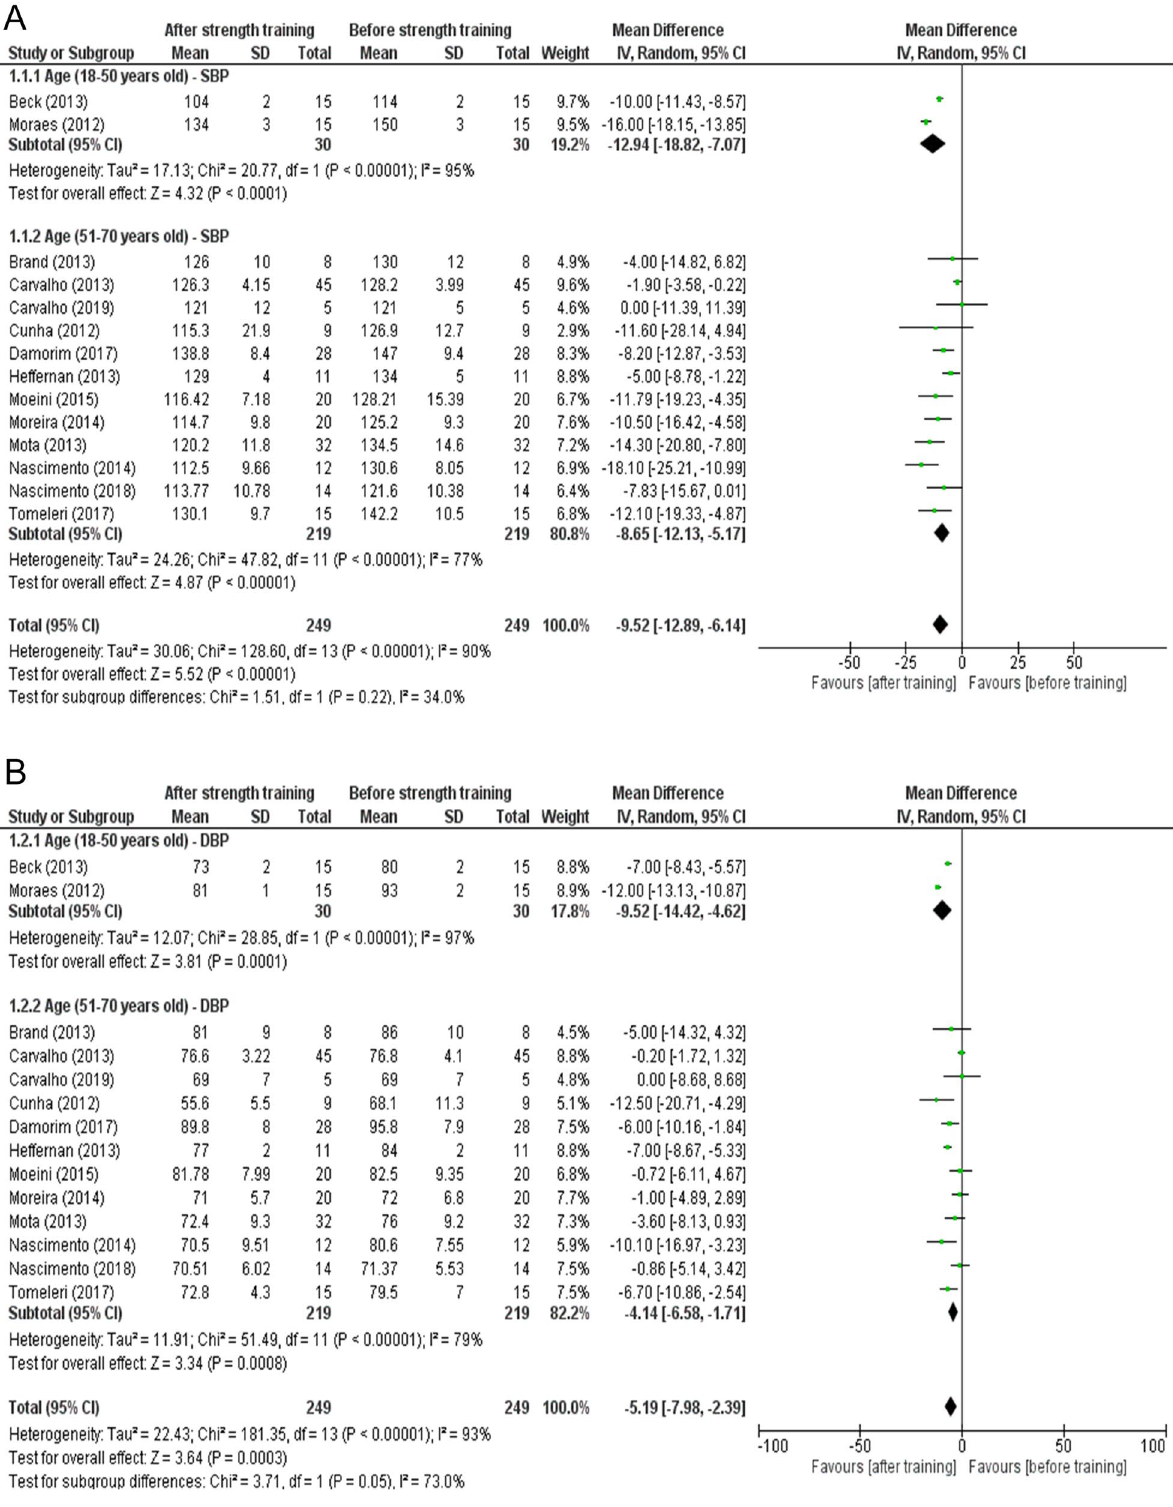
Figure 3. ( A ) Effects of strength training on systolic blood pressure in hypertensive individuals aged 18–50 and 51–70 years old. ( B ) Effects of strength training on diastolic blood pressure in hypertensive individuals with 18–50 and 51–70